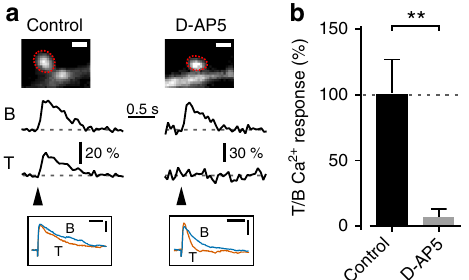
Fig. 5 Synaptically evoked spine Ca 2+ transients depend on